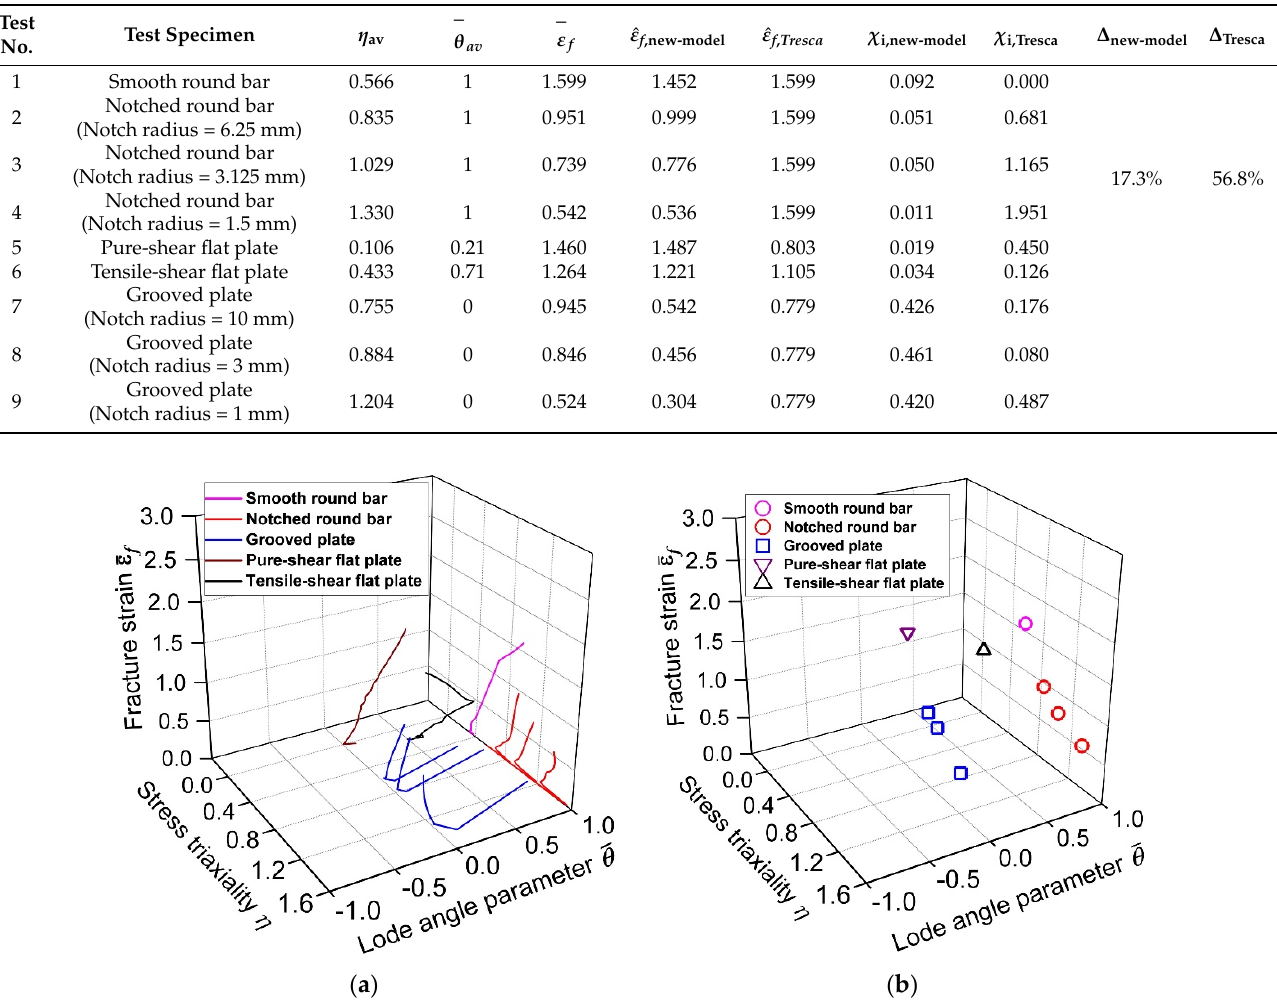
model, the following formula is used to calculate the prediction error of the new fracture model: